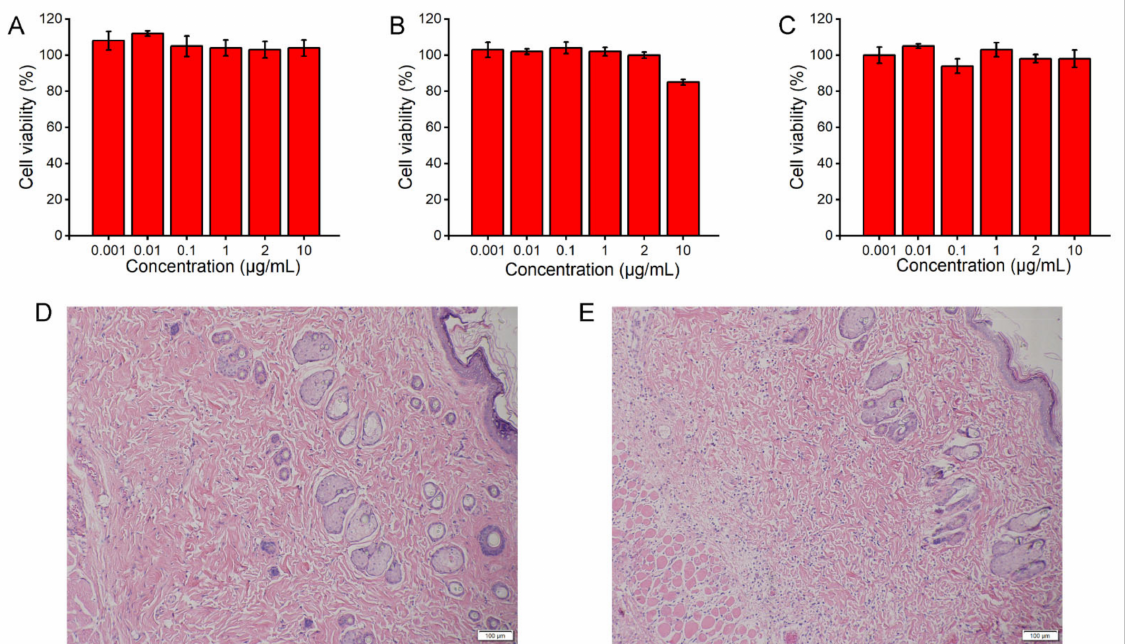
Figure 10. Biocompatibility study of MVL(F+E+I): Cytotoxicity assays of FBP ( A ), OP ( B ), and FOP ( C ) toward HeLa cells for 24 h. Data are shown as mean ± SD ( n = 6). H&E stained sections of subcutaneously injected blank solution ( D ) or MVL(F+E+I) ( E ) with surrounding tissue after 24 h, respectively. Scale bar = 100 µ